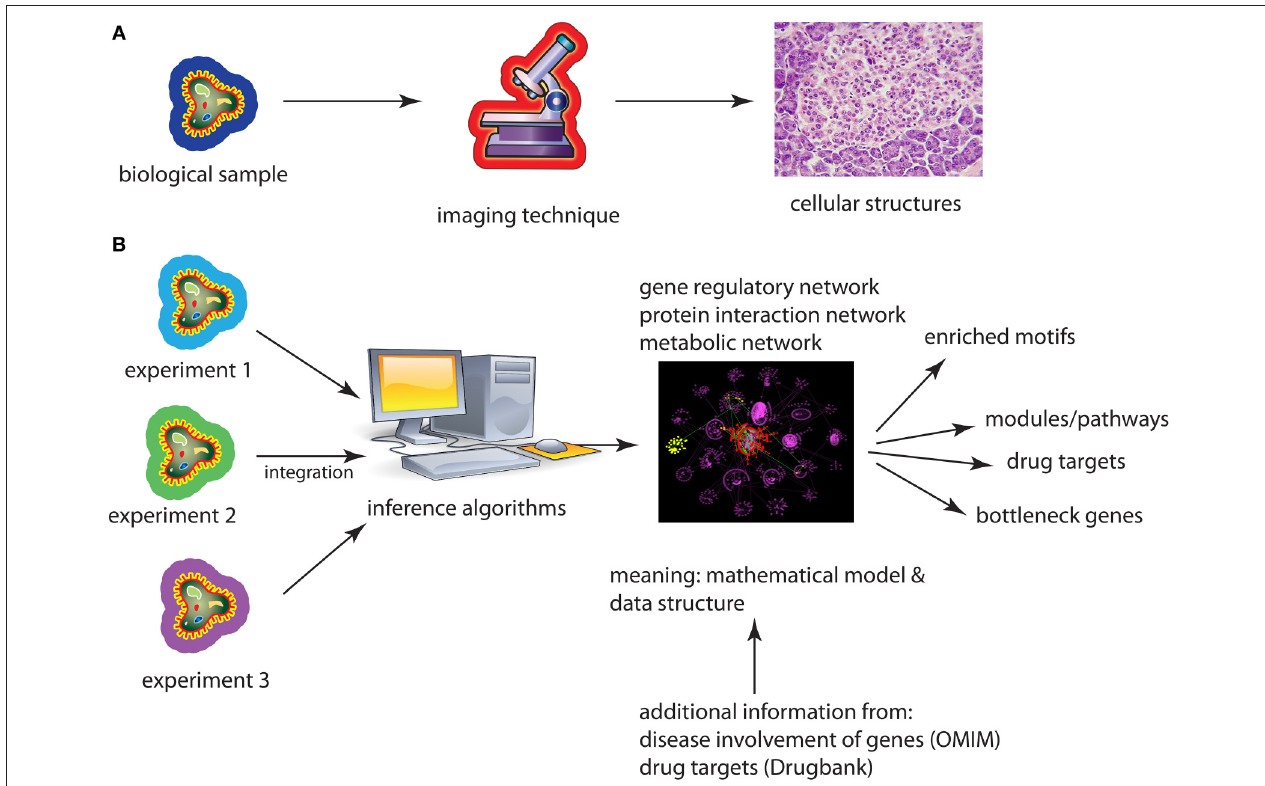
FIGURE 1 | (A) Application of an imaging technique results in a re-scaled image of the underlying biological sample. (B) Application of an inference method results in a biological network either from one or several different data sets. A subsequent analysis of the network provides then biological information about the used data sets coming from cell lines, model organisms, or